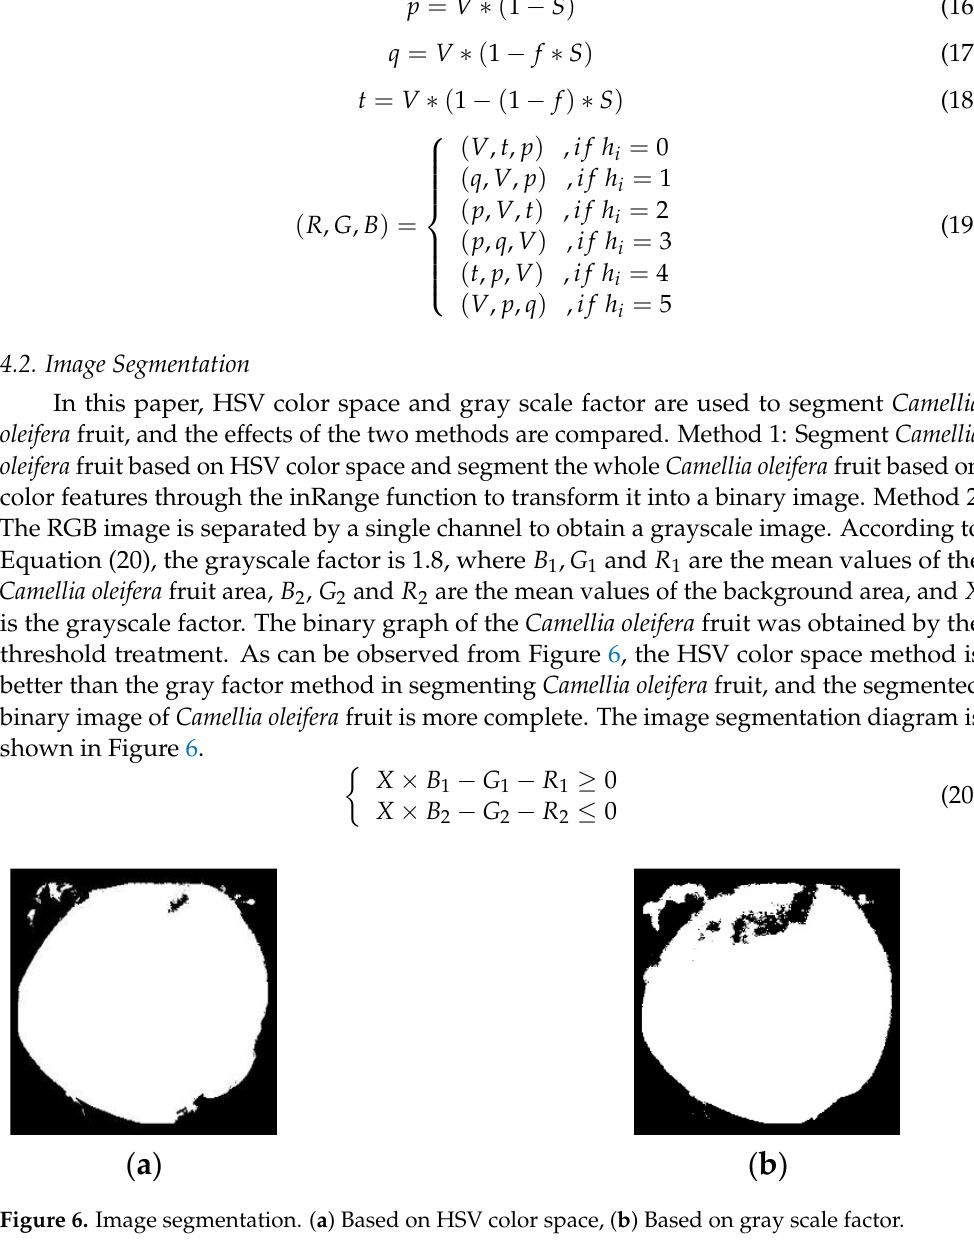
( b ) Figure 7. Morphological processing . ( a ) Close operation, ( b ) Open operation. 4.4. Centroid of Camellia oleifera Fruit Camellia oleifera fruit image processing after morphological processing is median fil- tered to remove noise; we smooth the edges of the binary image, and make its contour fitting effect better [34]. The mask operation extracts the Camellia oleifera fruit part of the target region. Therefore, the mask extraction operation is performed via a binary image obtained after morphological processing and an image with a 10-pixel expansion of image preprocessing. Edge detection is the process of locating the edge pixels of the Camellia oleifera fruit, so the Canny operator is used to detect the edge of the masked image to ob- tain the outline edge of the Camellia oleifera fruit. After edge detection, we need to use BLOBs to find the centroid of Camellia oleifera fruit. BLOB is a group of connected pixels with the same attributes in the image. The mo- ment is used to calculate the center of gravity, area, and other shape features of the shape. The calculation of the image’s geometric moment is